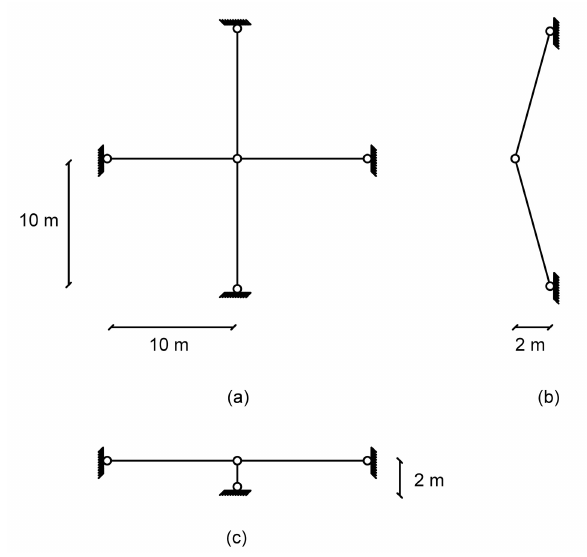
Figure 7: Geometry of the four-member lattice structure: (a) top view; (b) lateral view; (c) frontal